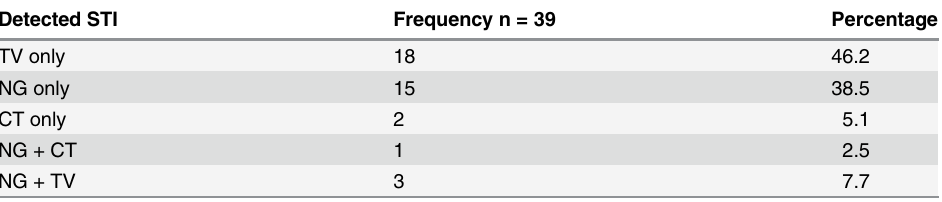
Table 2. Distribution pattern of sexually transmitted